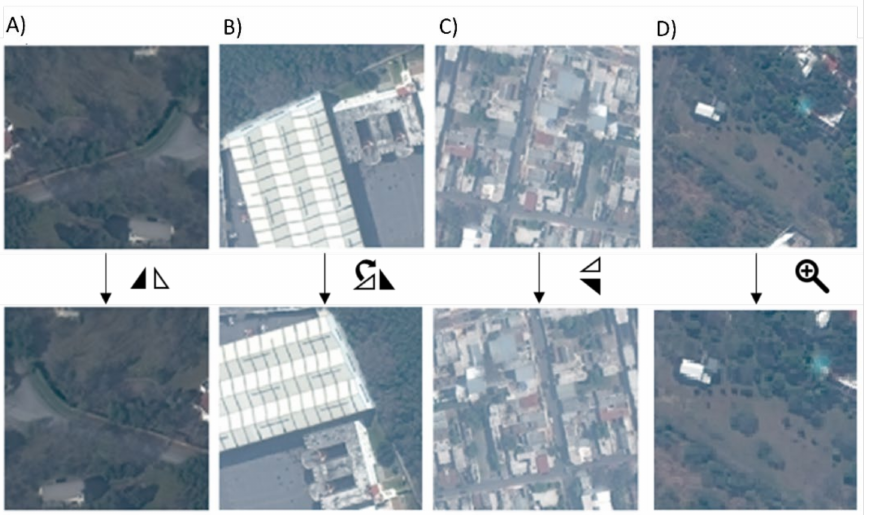
Figure 5. Example of images produced by data augmentation. ( A ) Horizontal flip; ( B ) random rotations; ( C ) vertical flip; ( D ) change in